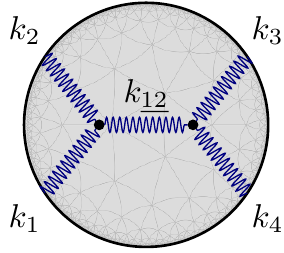
Figure 1 . A four point Witten